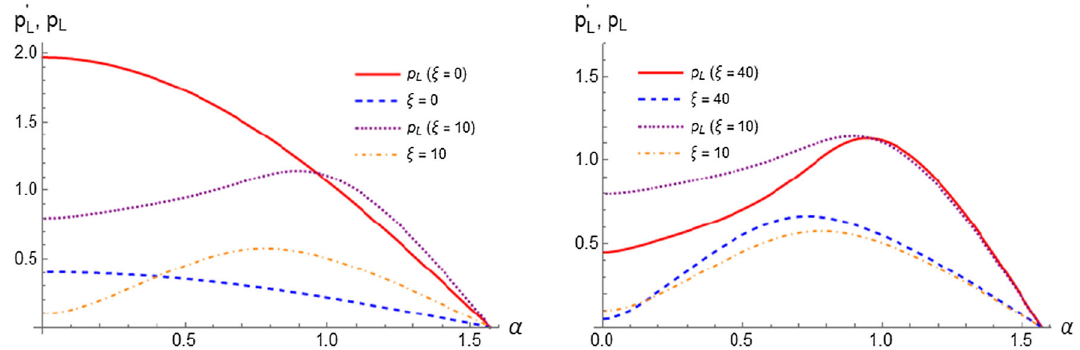
Fig. 14 Left: plots of the anisotropy dependence of the longitudinal momentum p L (α | ξ) for ξ = 0 (solid), ξ = 10 (dotted) and p (cid:2) ξ = 0 (dashed), ξ = 10 (dashed-dotted). Right: plots of the anisotropy